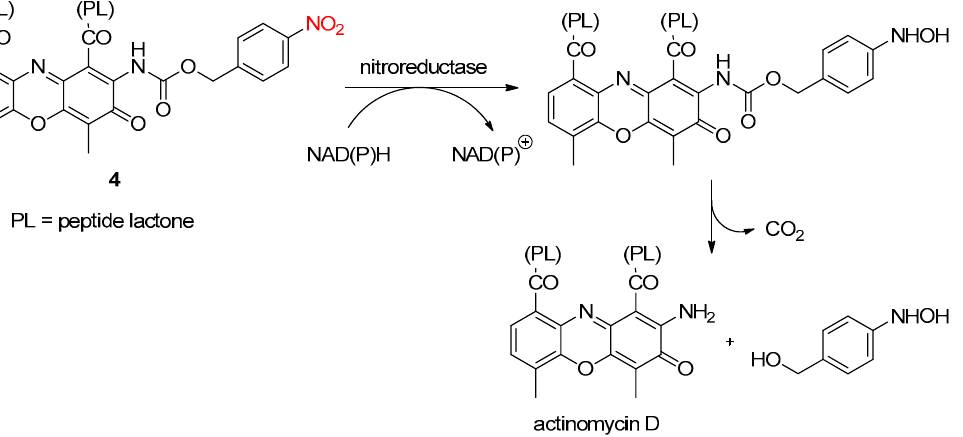
Scheme 6. The formation of actinomycin D from its 4-nitrobenzyloxycarbonyl derivative 4 by reduction of the nitro group by the nitroreductase enzyme, followed by self-immolation of the resulting 4-(hydroxyamino)benzyloxycarbonyl